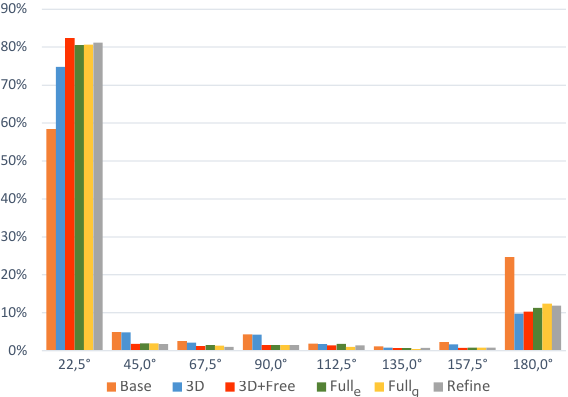
Table 3. Pose estimation results.